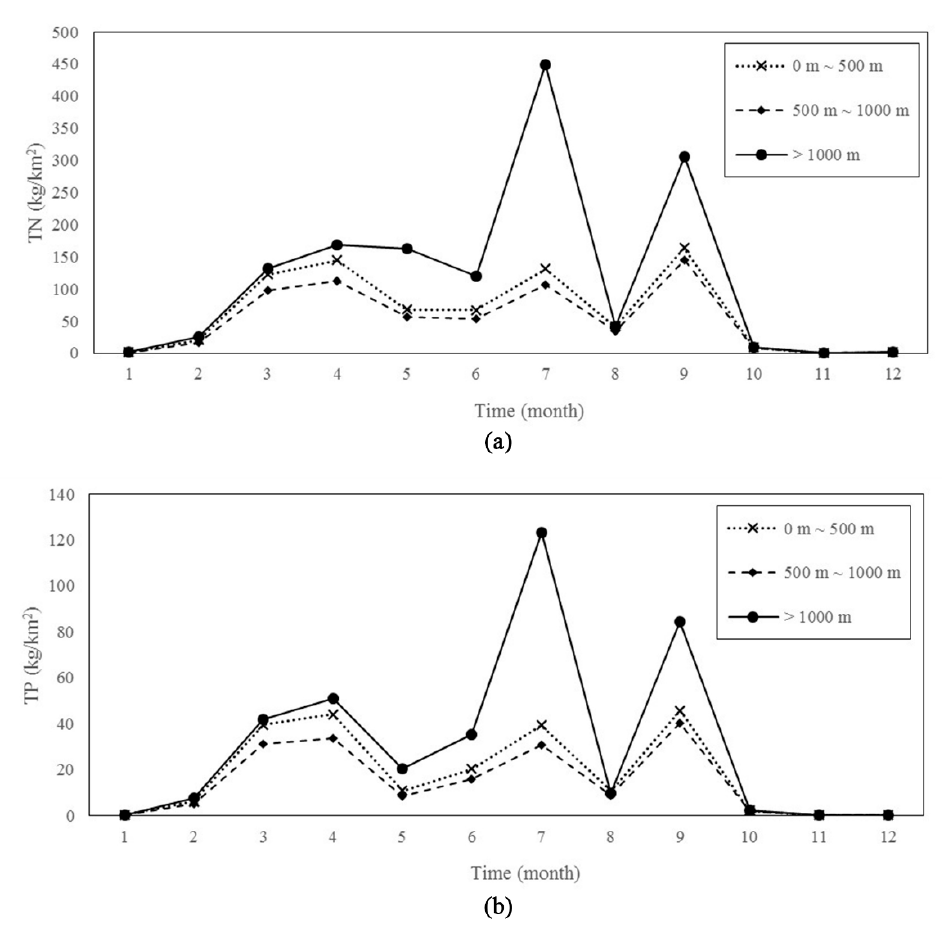
Figure 7. Annual output intensity of TN and TP in different DFR.